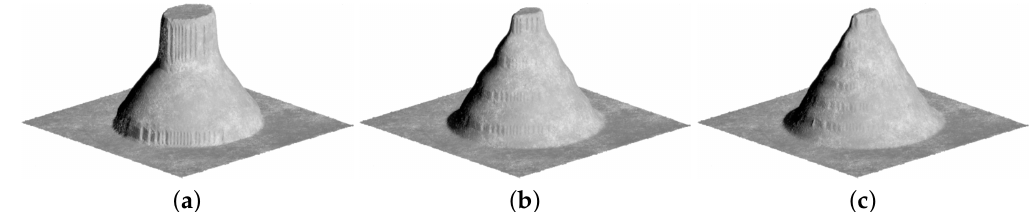
Figure 16. Comparison of the impact of the materials number on the model geometry (grid resolution: 100 × 100; fault height (max in centre): 0 (cid:54) ∆ h (cid:54) 1). ( a ) mat = 3. ( b ) mat = 6. ( c ) mat = 9.